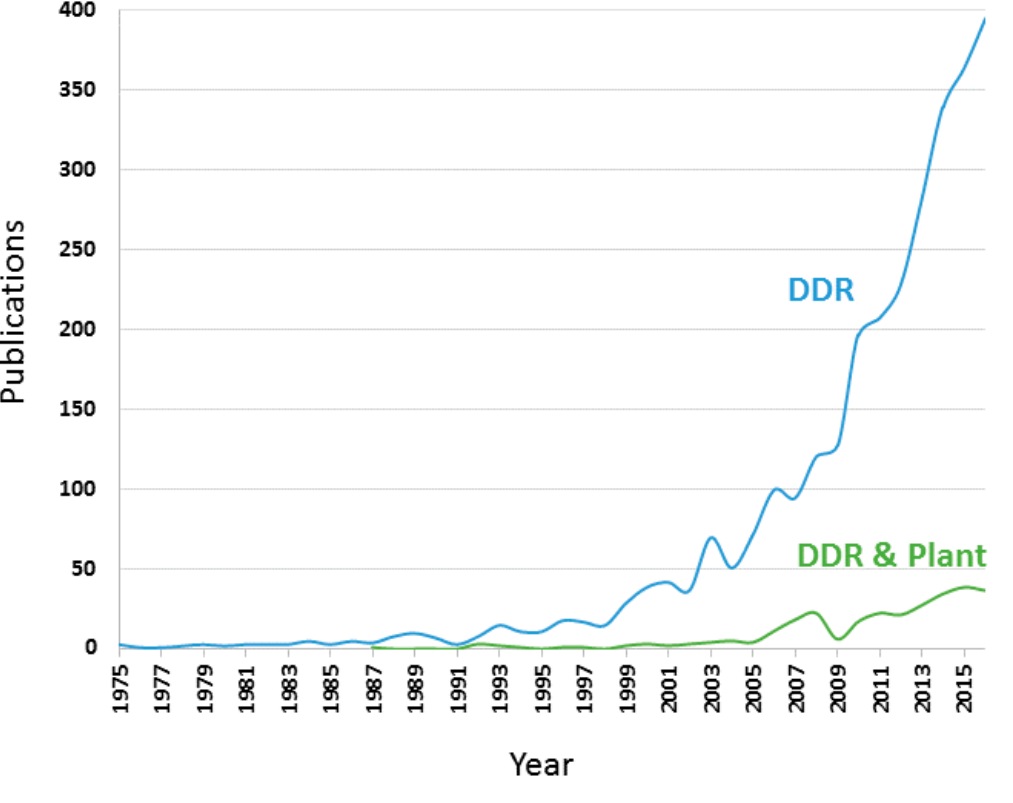
Figure 1. Trends in publications in the DNA damage repair (DDR) research field and the DDR research in plant field from 1975–2016.